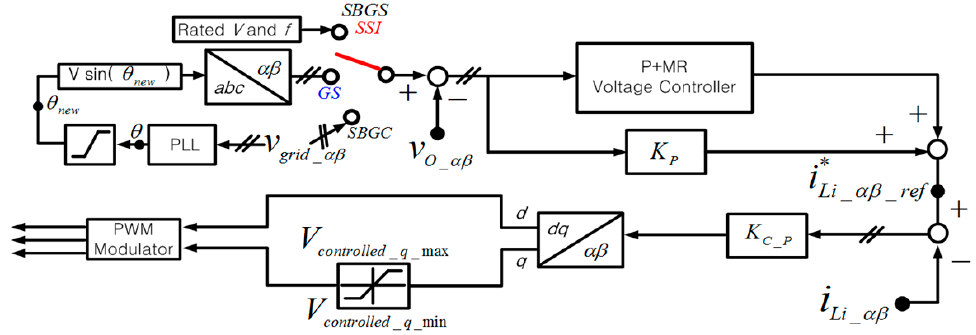
Figure 9. Block diagram of proposed P+MR based multi loop output voltage control scheme.